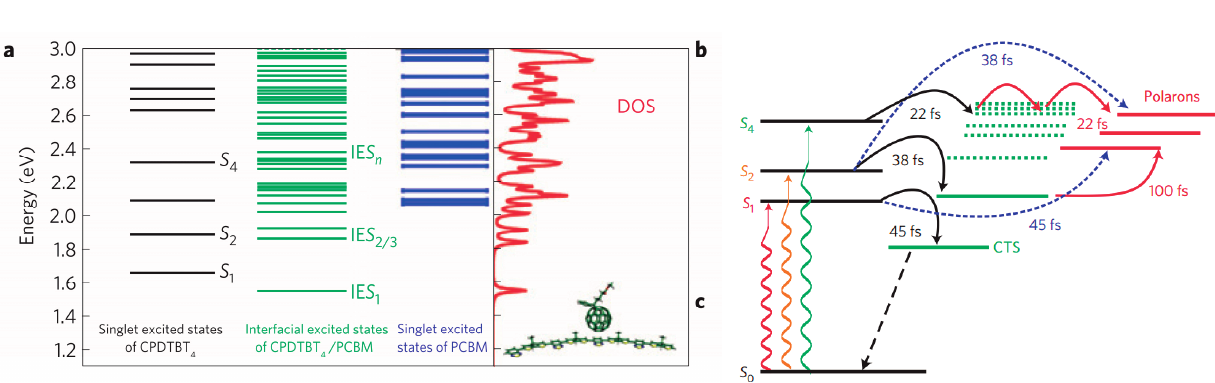
Figure 1. ( a , b , c ) Calculated excited-state energy levels for poly(2,6-(4,4-bis-(2-ethylhexyl)- 4 H -cyclopenta(2,1-b;3,4-b')-dithiophene)- alt -4,7-(2,1,3-benzothiadiazole)) oligomer featuring four repeat units (CPDTBT4), CPDTBT4/[6,6]-phenyl-C61-butyric acid methyl ester BM) and PC BM and the computed interfacial exciton state (IES), density of state (PC 60 60 (DOS) and sketch of the molecular dimer; Cited from [53]. Copyright 2013,